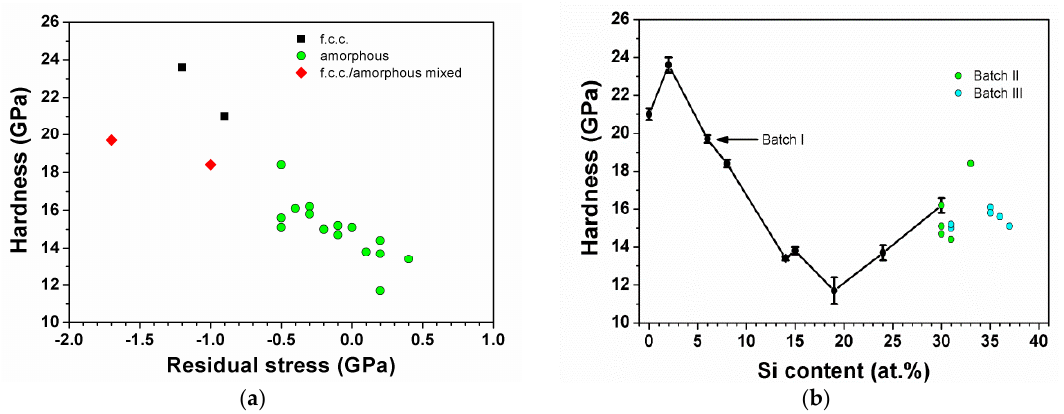
Figure 3. Relationships between nanoindentation hardness and ( a ) residual stress and ( b ) Si content of Zr–Si–N coatings.